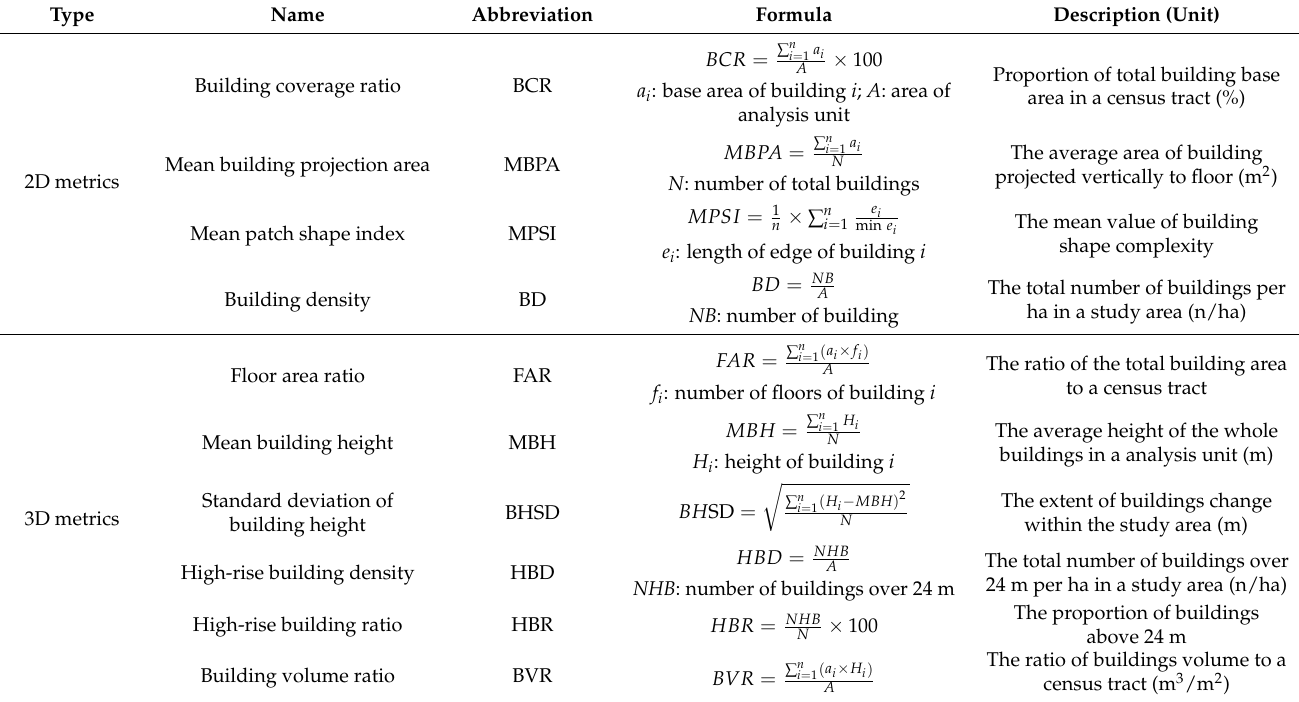
Table 1. Description of 2D and 3D building